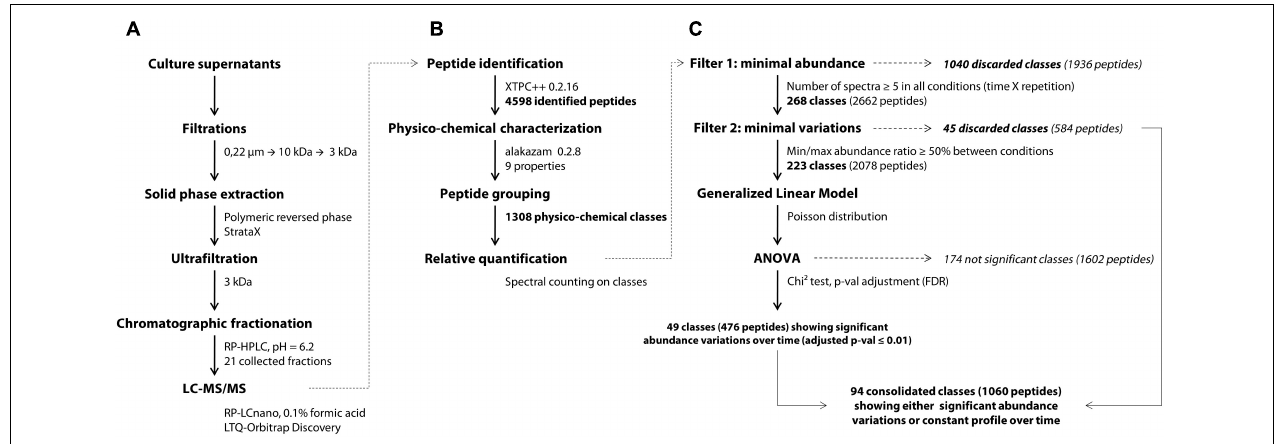
FIGURE 1 | General workflow of the peptidomics analytical pipeline, starting from the experimental part (A) to the bioinformatic (B) and statistical analyses (C) . XTPC++, X!Tandem Pipeline (C++).